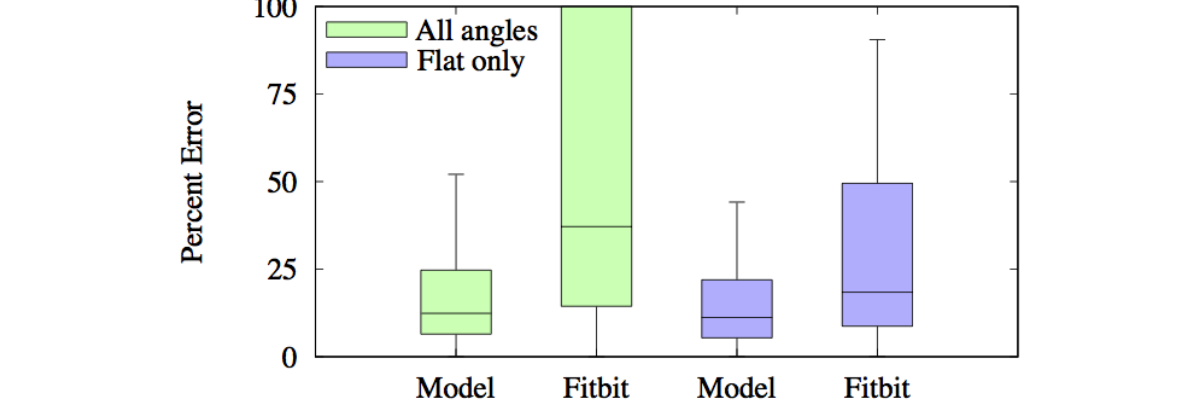
Figure 7. Boxplots of the percent errors of predictions made by the model and Fitbit Surge. Errors have been estimated via equation 9 in Figure 4.